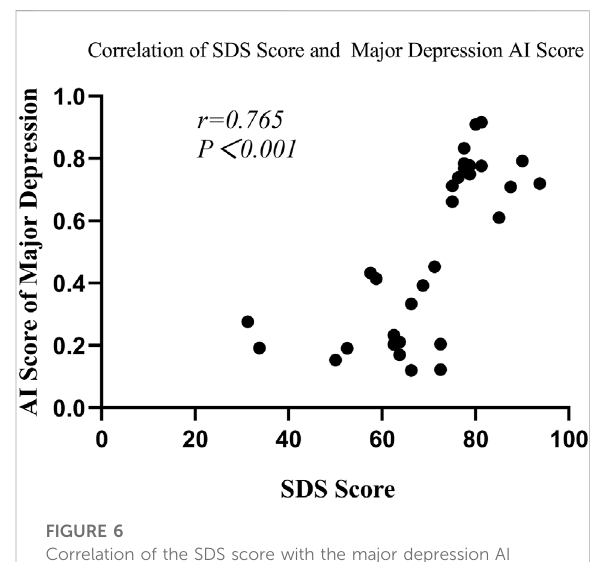
FIGURE 7 Correlation of the SAS score with the major depression AI